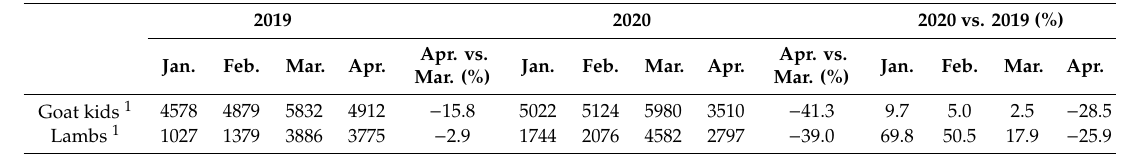
Table3. Numberofanimalssacrificedbymonthin2019and2020from2smallruminantslaughterhouses, with intermonthly (April vs. March) and interannual (2020 vs. 2019) comparisons calculated as a percentage of change from baseline